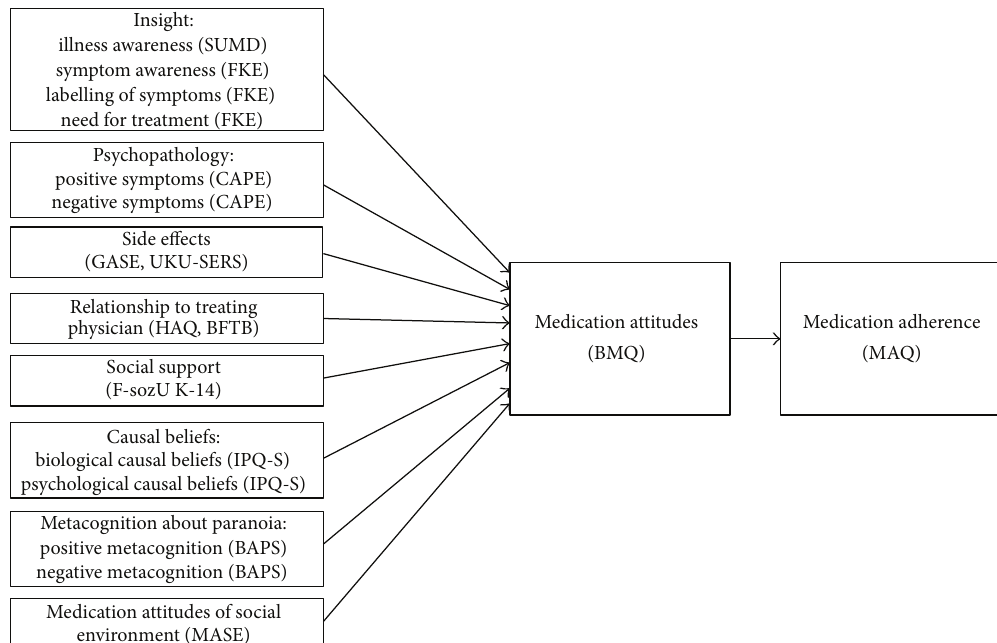
Figure 1: Process model to explain the variance in medication adherence with medication attitudes and possible predictors.